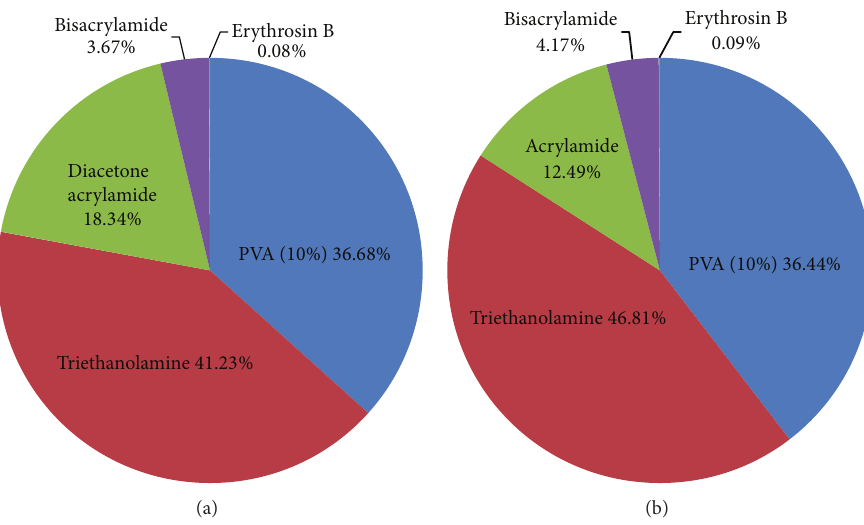
Figure 1: Pie chart representations of the composition of the DA and AA